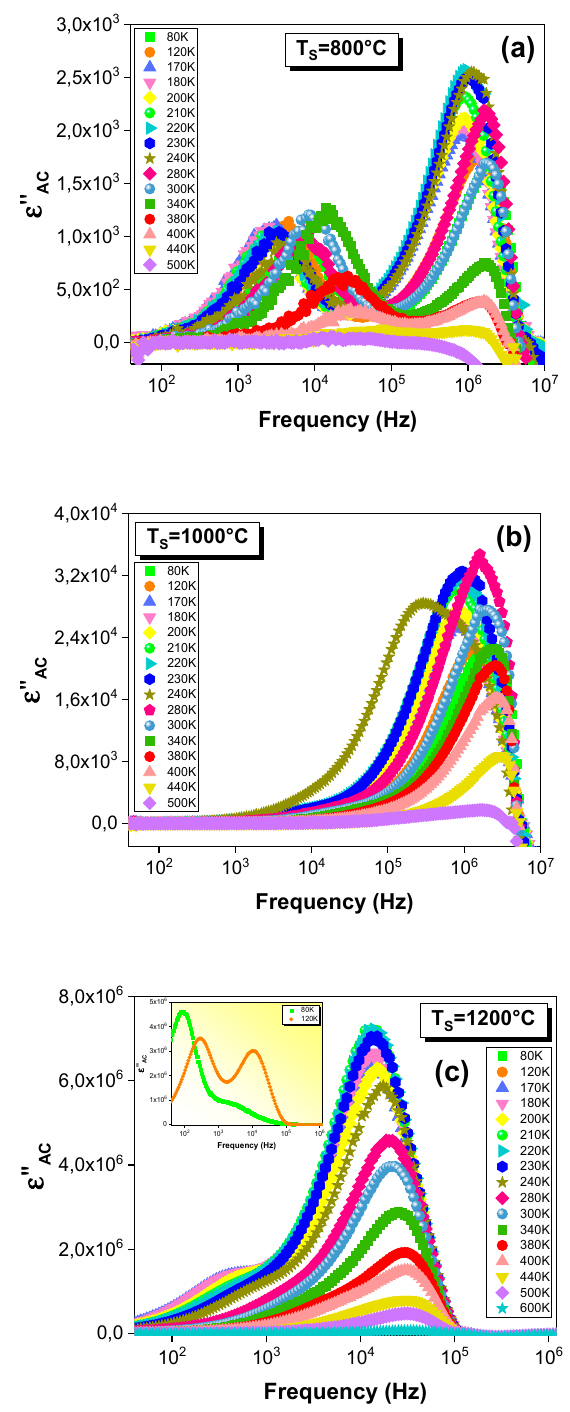
Figure 6. Spectra of the imaginary part of the relative dielectric permittivity ( ε″ ) at different temperatures for the La0.9Sr0.1MnO 3 system sintered at ( a ) 800, ( b ) 1000 and ( c ) 1200 °C. Hence, the high values of the ε′ may partially refer to the existence of space-charge zones that are produced by a localized accumulation of the charges on the electrode-sam- ple contact and on the interface between the grains and the grain boundaries [3,4]. This is attributed to a Maxwell–Wagner (MW) type of interfacial polarization [63,64]. According to the MW [63,64] theory of interfacial polarization, the high values of the dielectric